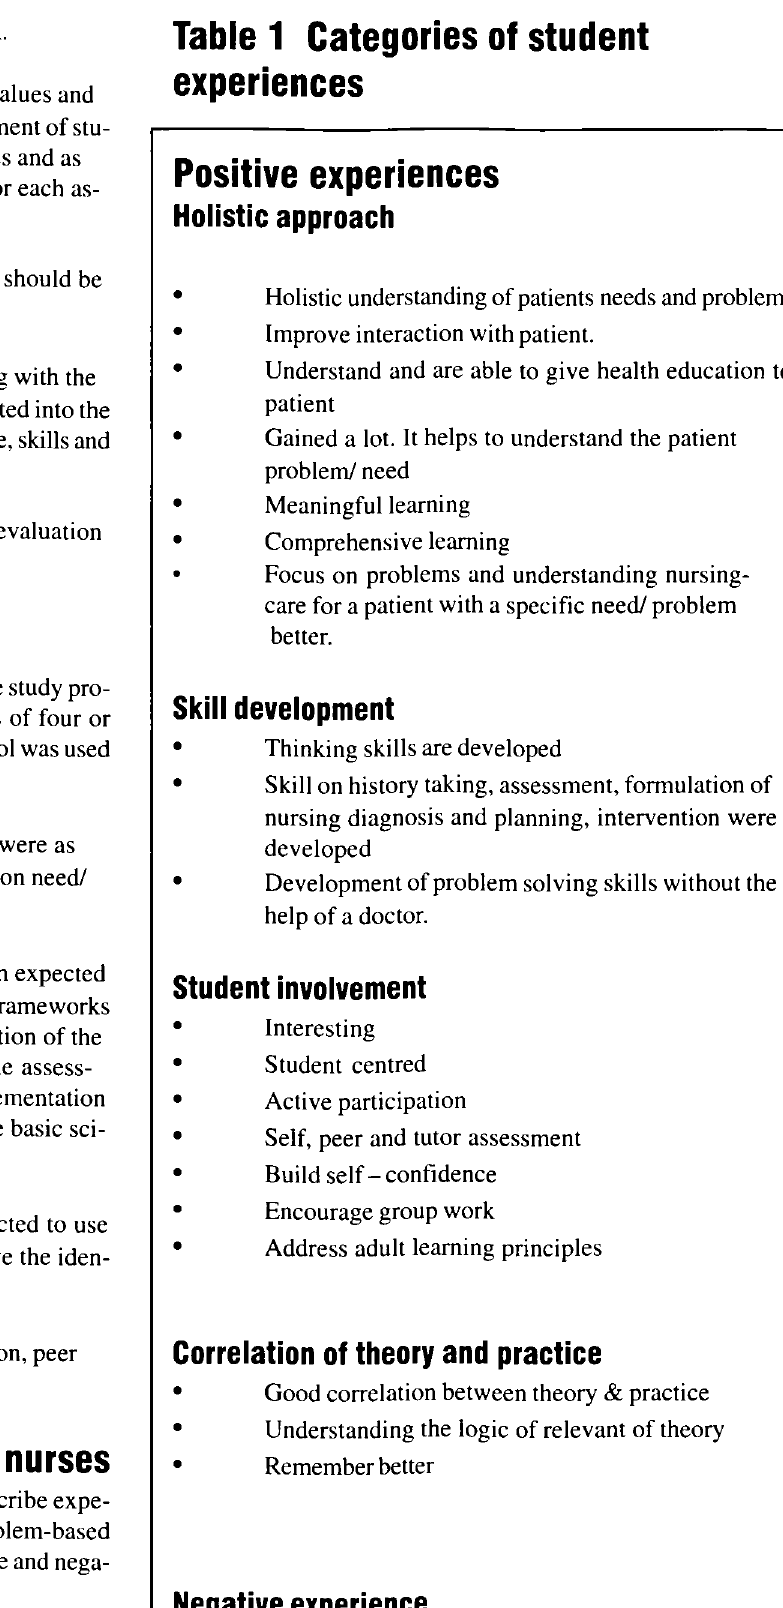
Table 1: Provides a schematic representation of six main cat­ egories and sub categories of student experiences, which were generated from the coding of naive